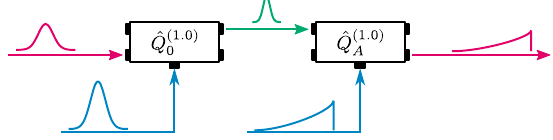
FIG. 9. TM reshaping of a single photon. A QPG first converts the red single photon to the green channel. A second QPG then reshapes the photon during